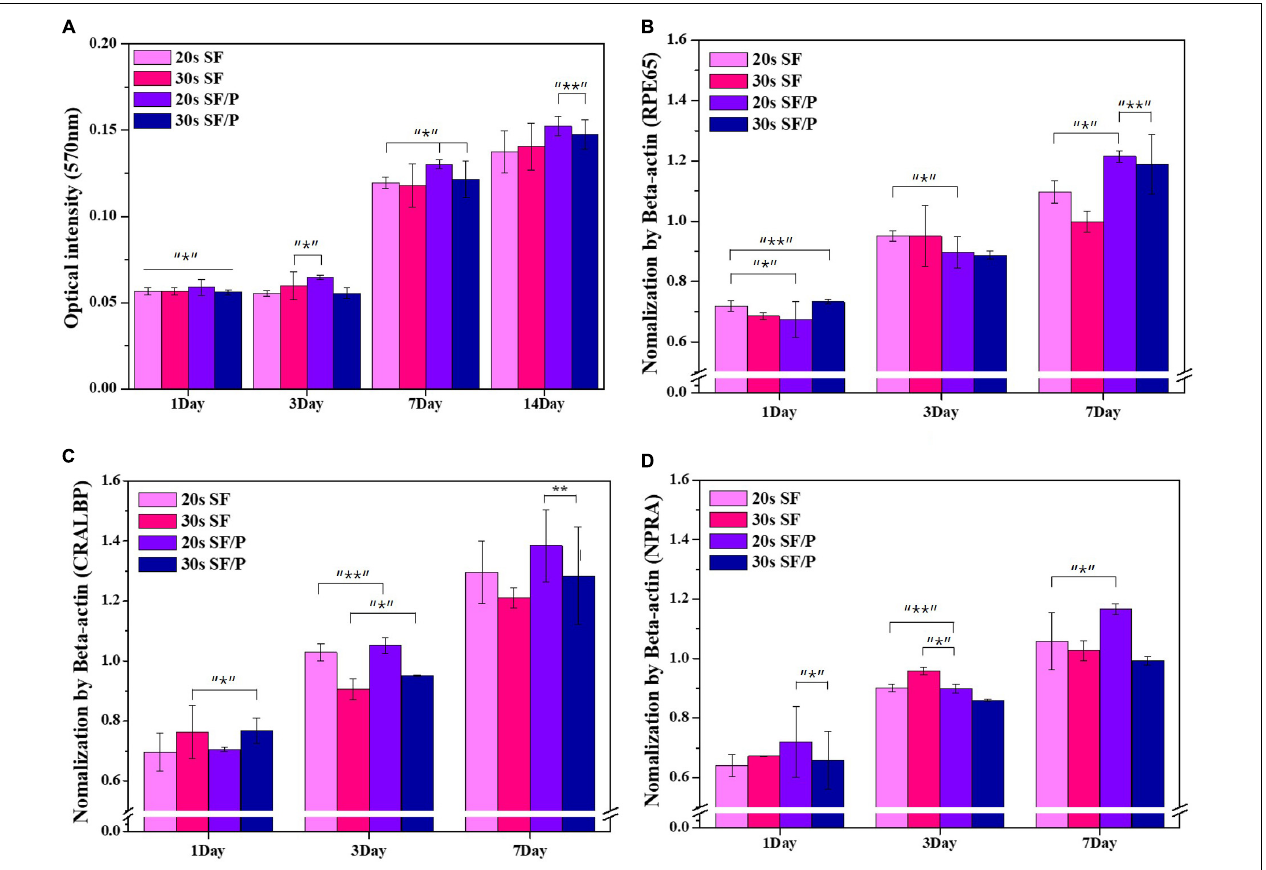
FIGURE 4 | (A) Cell proliferation result by MTT assay of RPE cell on SF and SF/P hydrogels ( n = 3 in each group; * P < 0.05, ** P < 0.01). Gene expression of RPE on SF/P hydrogels was analyzed by RT-PCR after 1, 3, and 7 days. Quantitative analysis of RPE65 (B) , NRPA (C) , and CRALBP (D) by normalization of ß-actin ( n = 3; * p < 0.5, ** p < 0.05, and *** p <